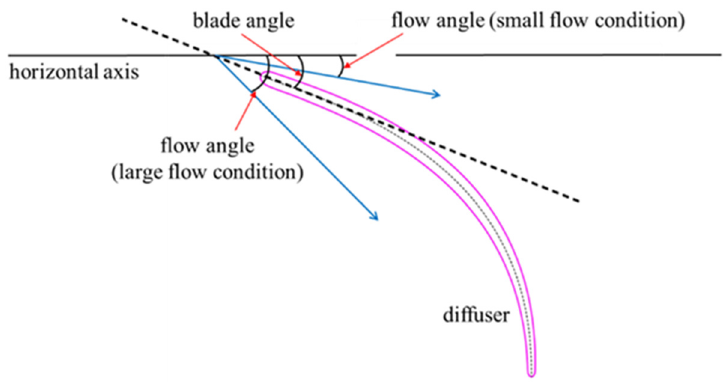
Figure 8. Diagram of flow angle.